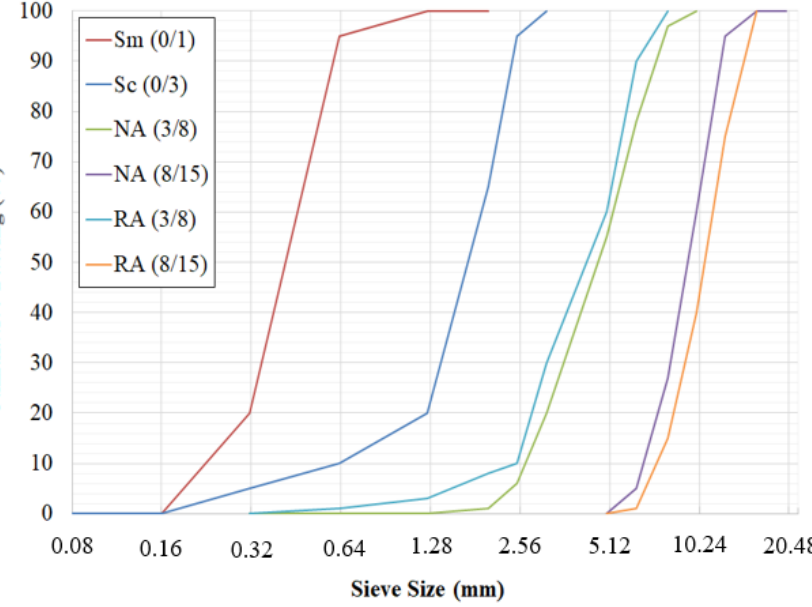
Figure 1. Grading curves of different types of aggregates